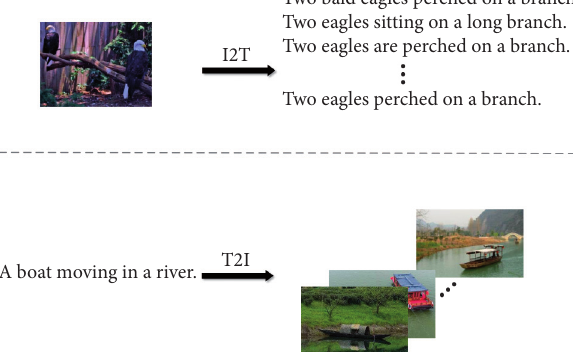
Figure 1: Using an image to retrieve texts and a text to retrieve